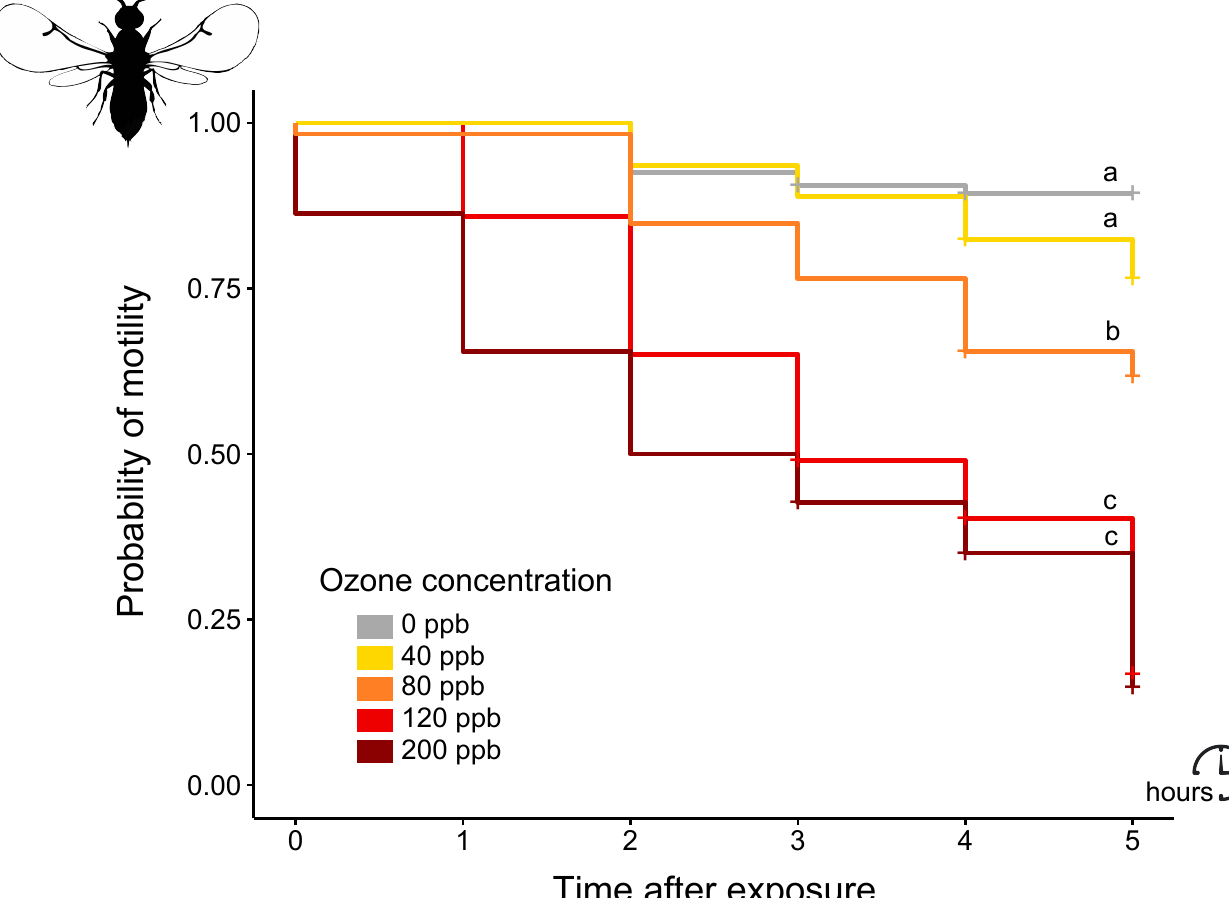
Figure 2. Kaplan–Meier curves depicting the probability of motility over time for each O 3 regime. Crosses indicate points of censored data. Different letters indicate significant differences ( p < 0.05) in the probability of motility between O 3 regimes based on pairwise log-rank